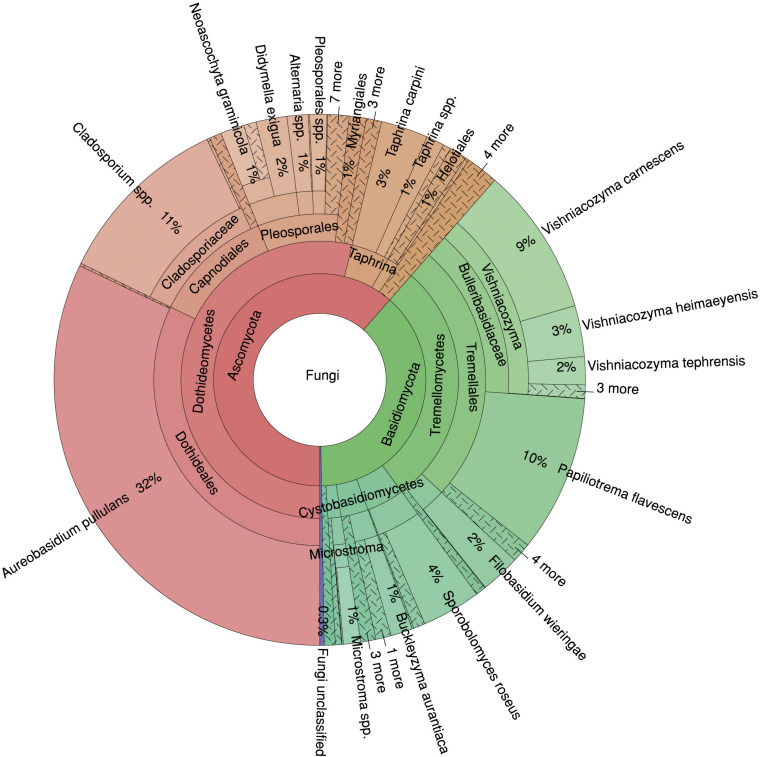
Relative proportions of taxa in the mycobiome of Fraxinus excelsior. The Krona diagram shows six taxonomic levels from phylum to species.